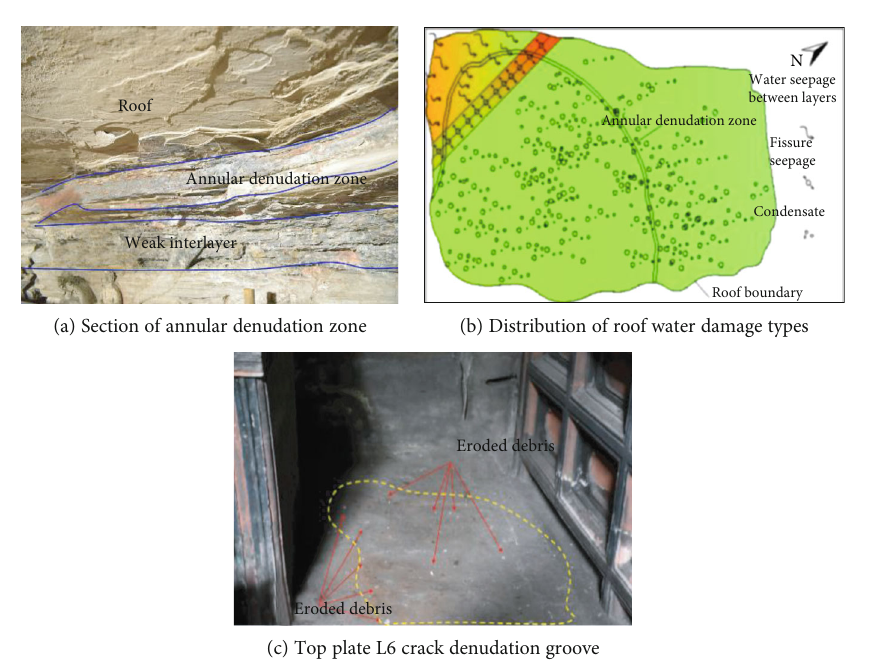
Figure 2: Distribution map of cracks around the Yuanjue Cave.